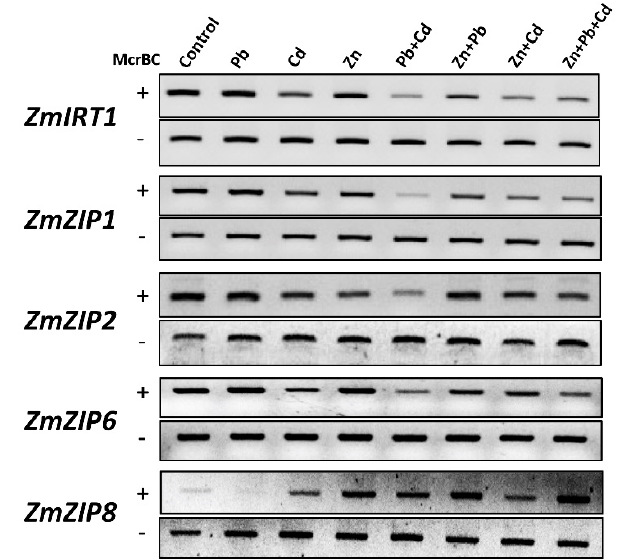
Figure 6. DNA methylation levels at the promoter of selected ZIP transporters in response to Pb / Cd / Zn applied alone and in combinations. DNA was digested with McrBc and equal amounts of digested or undigested DNA were used as template for PCR. McrBC digests the methylated DNA; therefore, lighter band intensity reflects higher DNA methylation level.